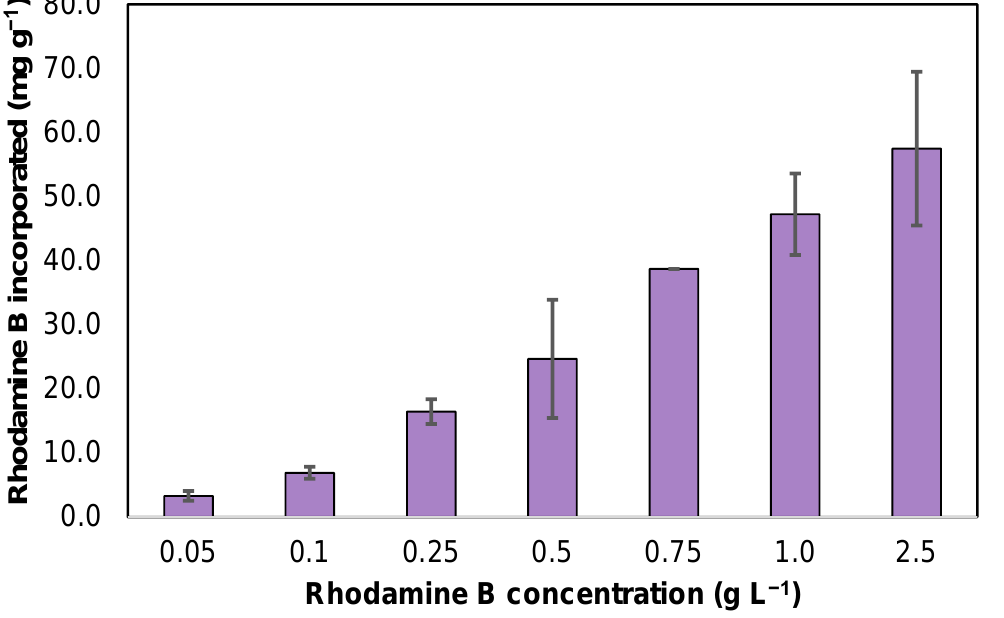
Figure 2. Effect of initial rhodamine B concentration on the amount of rhodamine B incorporated on the obtained solid products.